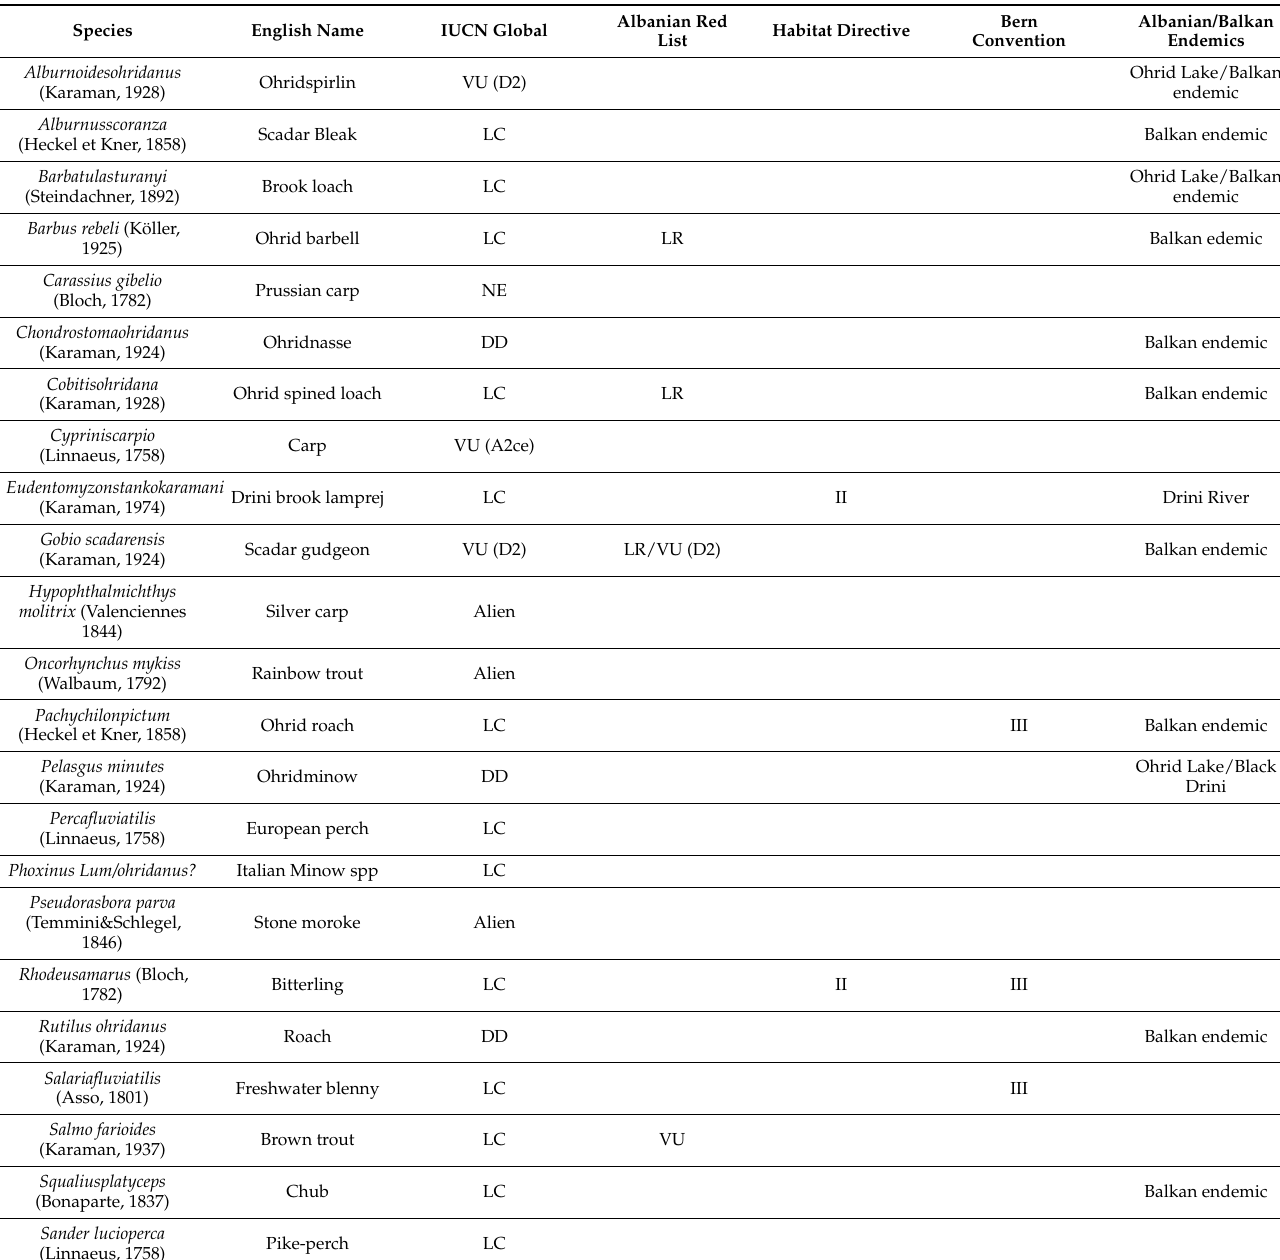
Table 1. Fish species recorded during the survey and current conservation